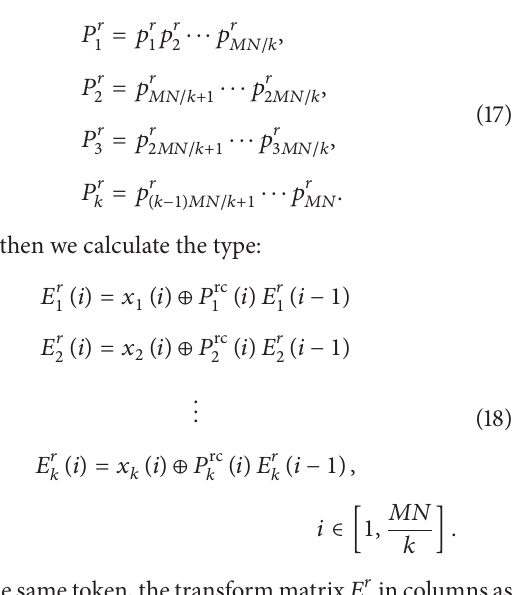
algorithm in Sections 4.1–4.4 of the image encryption process for optimization operation, in order to obtain the